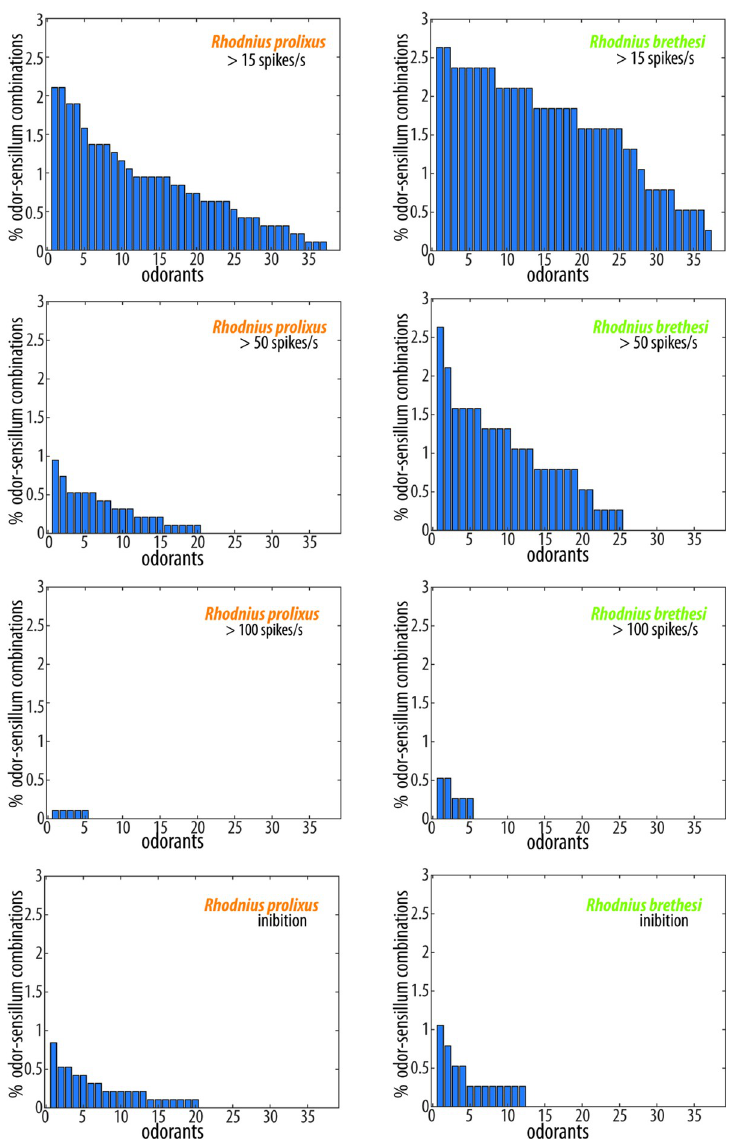
Fig 5. Response properties of grooved peg sensilla. Percentage of odor-sensillum combinations activated at the indicated firing rate by each odorant. The total number of odor-sensillum combinations was 950 for R . prolixus and 380 for R . brethesi . Odorants are sorted along the x-axis according to the number of sensilla that they activate. Responses with a frequency under -15 spikes/s are considered inhibitory.